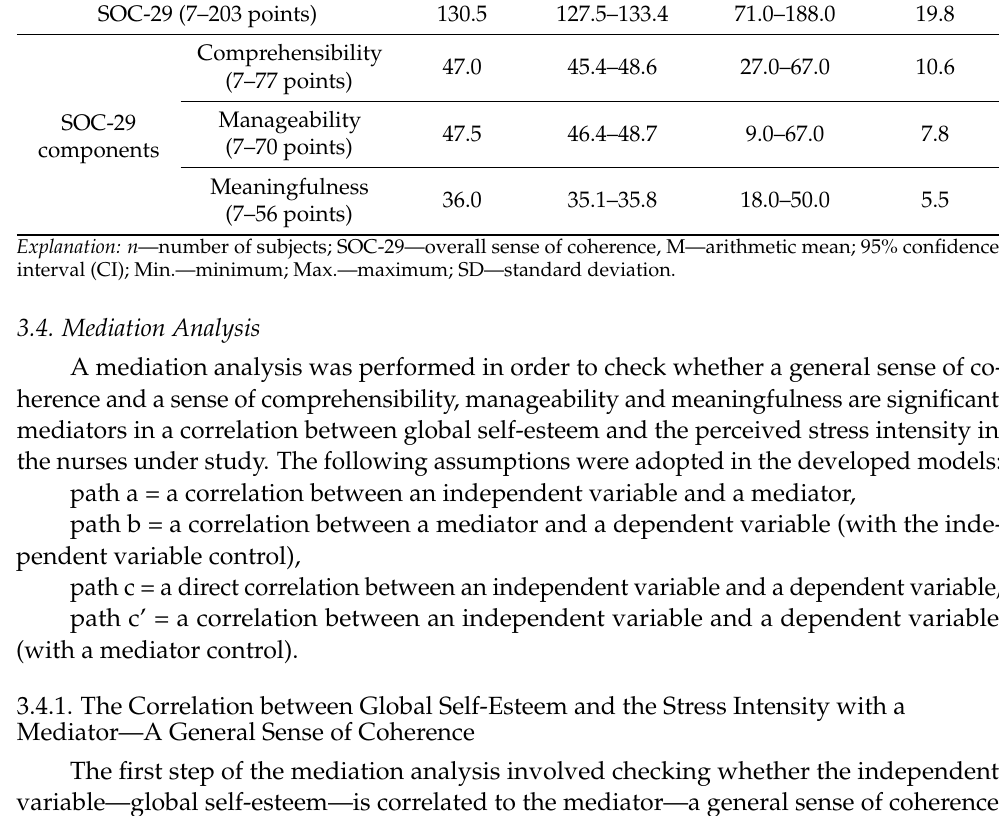
Table 3. Results of descriptive statistics for the sense of coherence in the study group. n = 176 Variables M 95% Cl Min.–Max. SD SOC-29 (7–203 points)